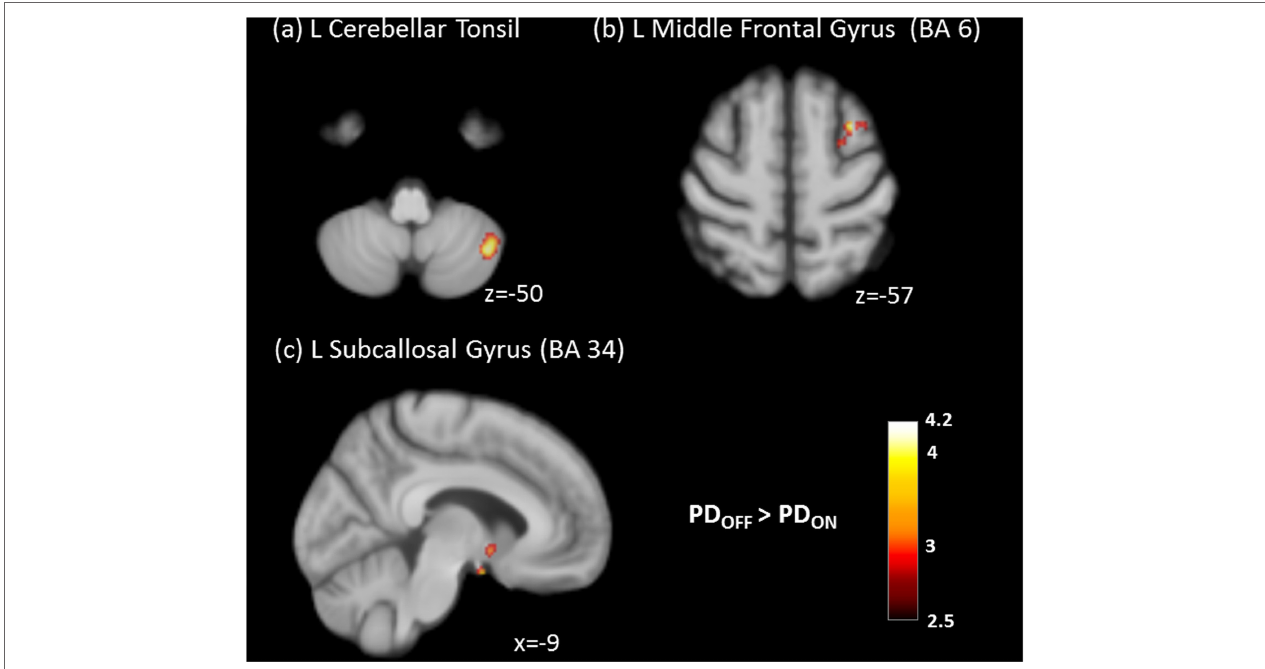
FigUre 3 | Significantly decreased absolute cerebral blood flow of (a) left cerebellar tonsil, (B) left middle frontal gyrus, and (c) left subcallosal gyrus in the ON state compared to the OFF state in Parkinson’s disease (PD) patients (cluster level statistics, P < 0.05, family-wise error